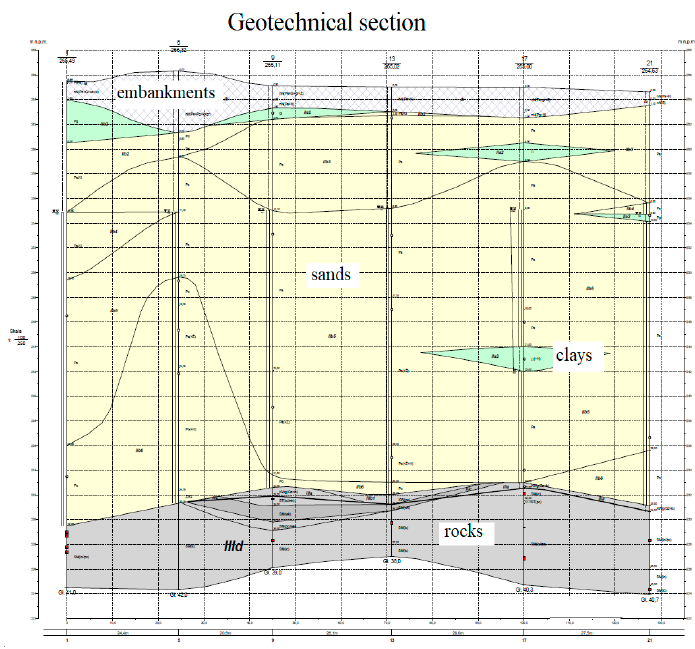
Figure 6. Exemplary geotechnical cross-section showing the ground conditions in the tunnel under construction.